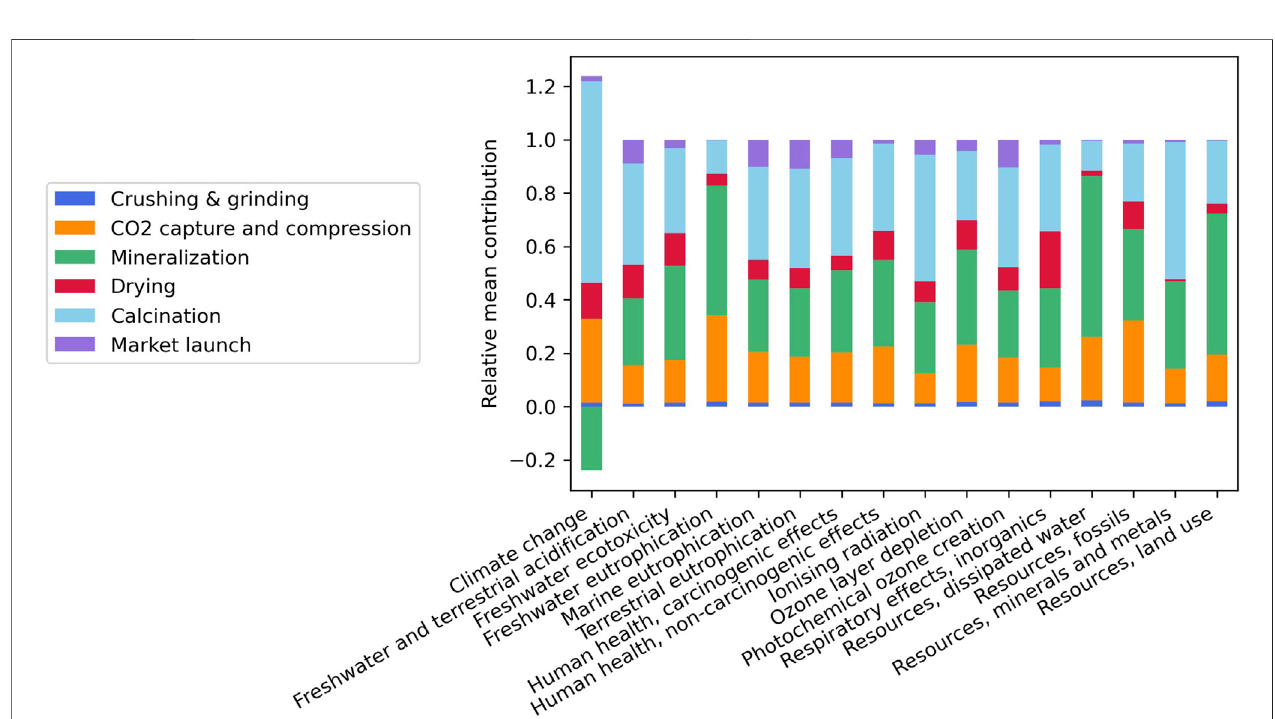
FIGURE 6 | Mean contribution of the nickel slag valorization operations for ILCD midpoint impacts at the 2035 production time-horizon.